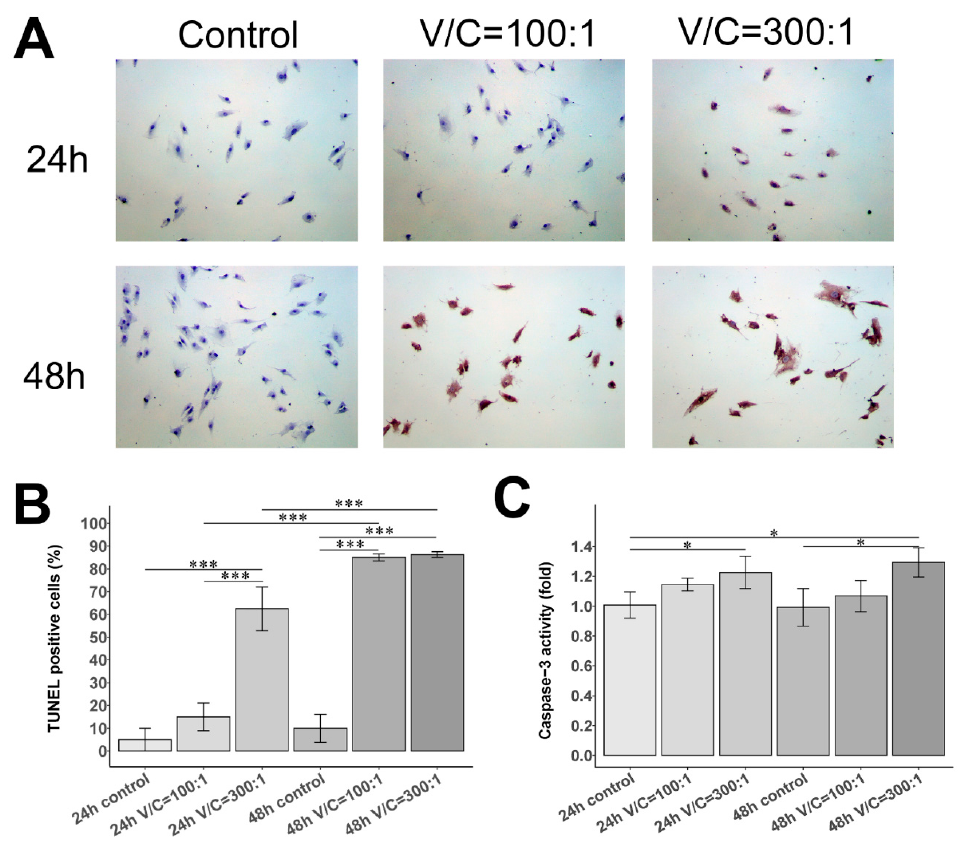
Figure 3. Apoptosis of FLS with NDMV treatment using TUNEL assay and caspase-3 activity assay. ( A ) Representative images of FLS exposed with and without different vesicle/cell (V/C) ratios of 100:1 or 300:1 for 24 h or 48 h by TUNEL assay; ×100 magnification. ( B ) The histogram of TUNEL-positive cells. ( C ) The histogram of caspase-3 activity in control, V/C = 100:1 and V/C = 300:1 groups for 24 h or 48 h. Data are expressed as mean (±SE), n = 3 independent experiments performed in different FLS clones. Significant differences between groups were identified using the Kruskal–Wallis test followed by the Conover–Inman test. * p < 0.05; *** p < 0.001.